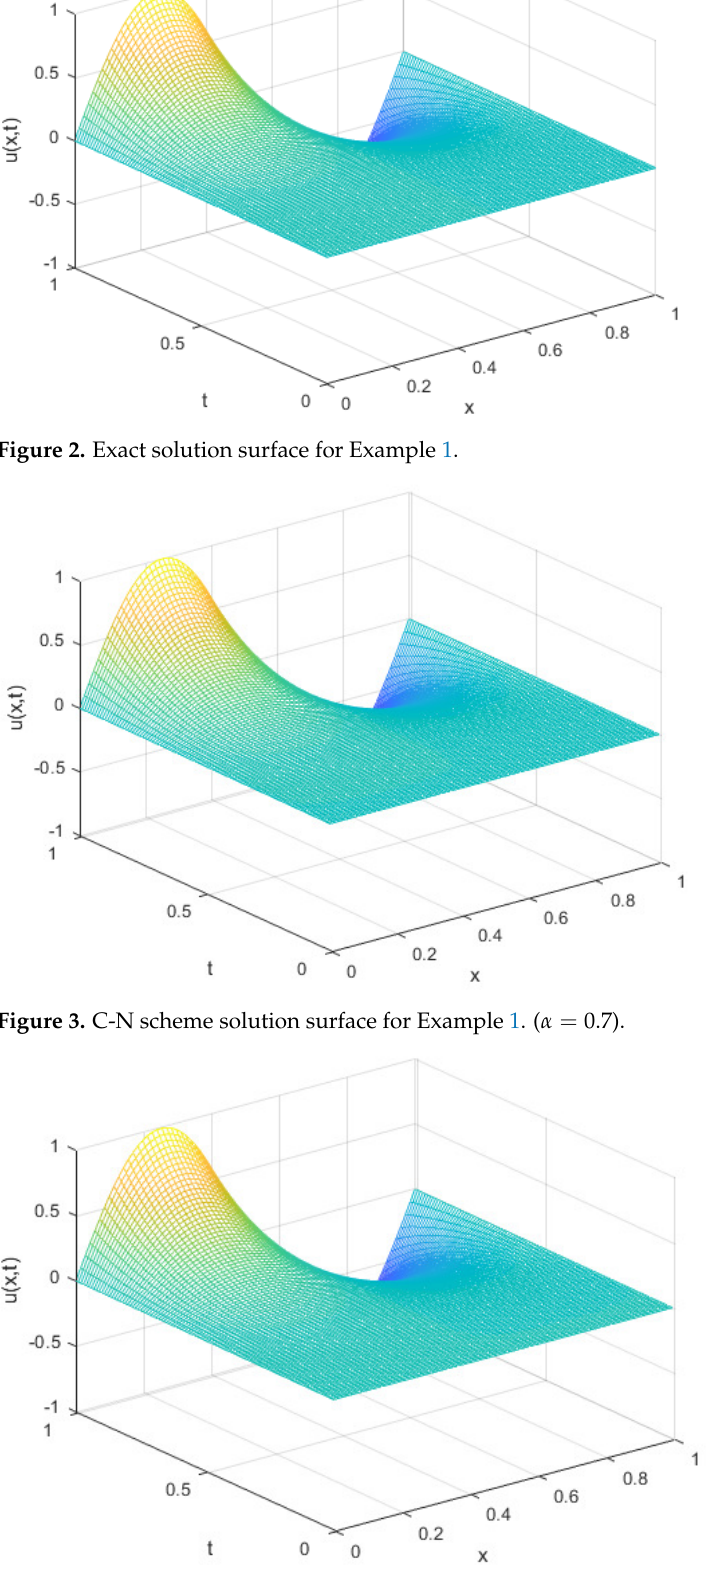
Figure 4. HASC-N scheme solution surface for Example 1. ( α =